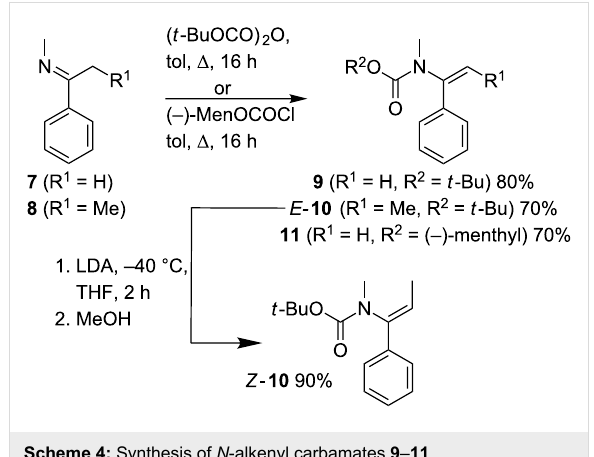
Table 3: Carbolithiation of urea 5 .